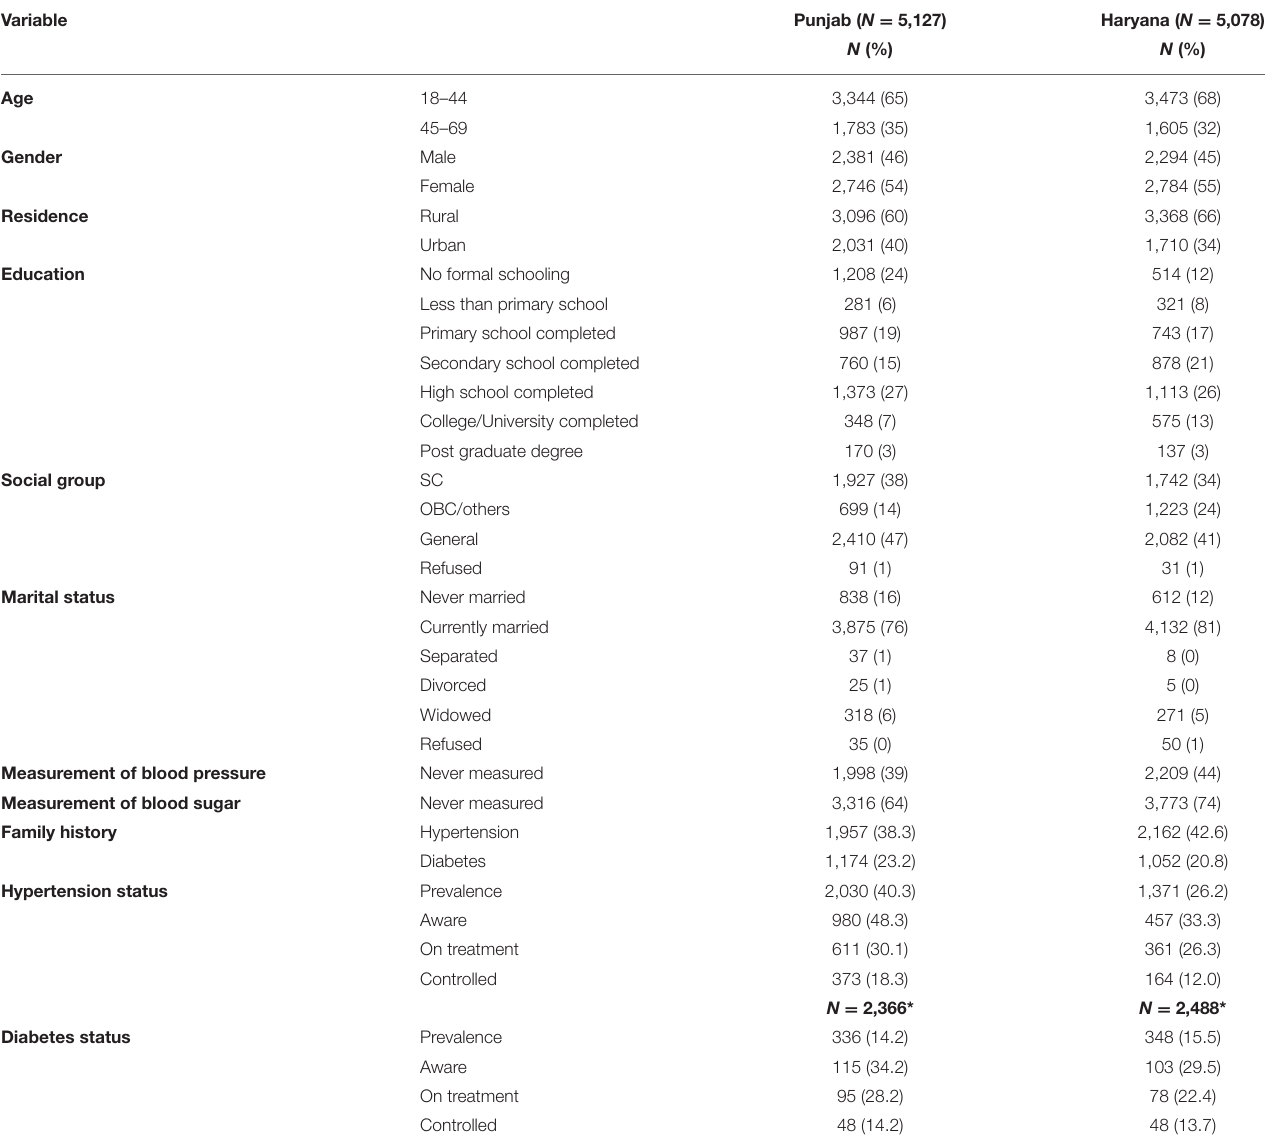
TABLE 1 | Socio-demographic and behavioral characteristics of the participants, Punjab and Haryana.